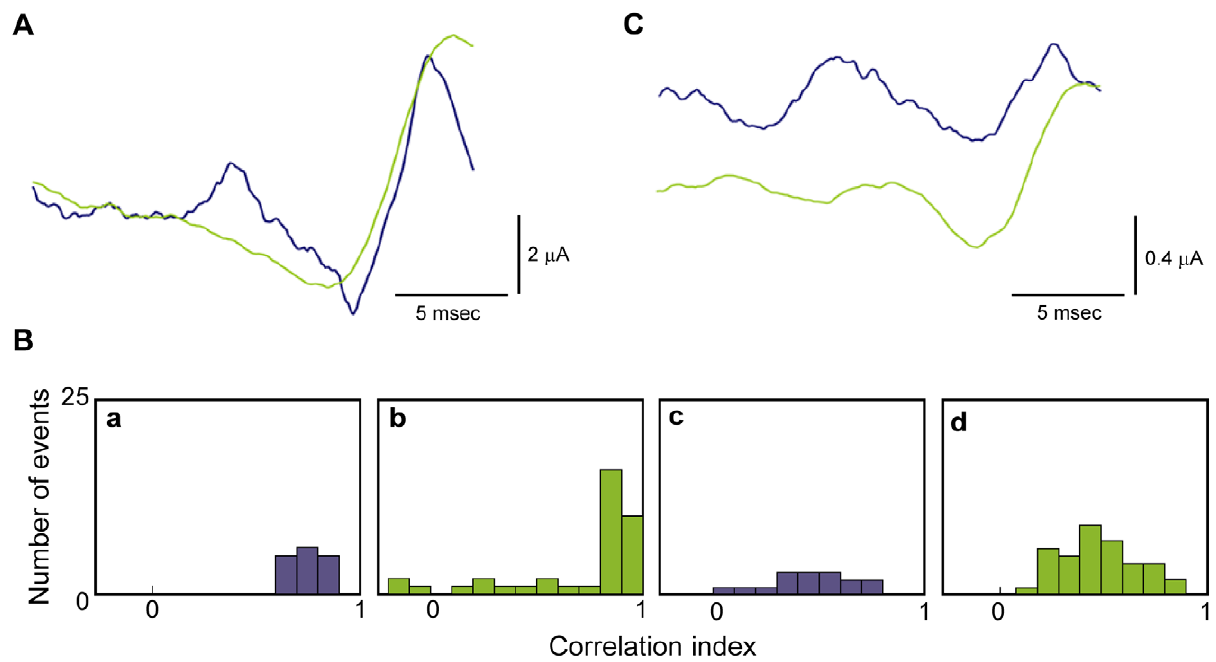
Figure 7. Effects of PSC duration on optimality. A ) We repeated the experiments carried out in Figure 3 to determine the optimal shape for eliciting an action potential with PSCs having either a long (20 msec) decay constant (green curve) or short (1 msec) decay constant (blue curve). These signals are particularly different 5 to 10 msec prior to the action potential. During this region, short PSCs excite the neuron, whereas long PSCs inhibit the neuron. B ) Correlation analysis of the short versus long PSC results as described in the text. C ) The intracellular pH of the axon was elevated to increase axon excitability (15) and the experiments in A were repeated. For the axon with enhanced excitability, the difference between the optimal signals comprised of short PSCs and those comprised of long PSCs was more